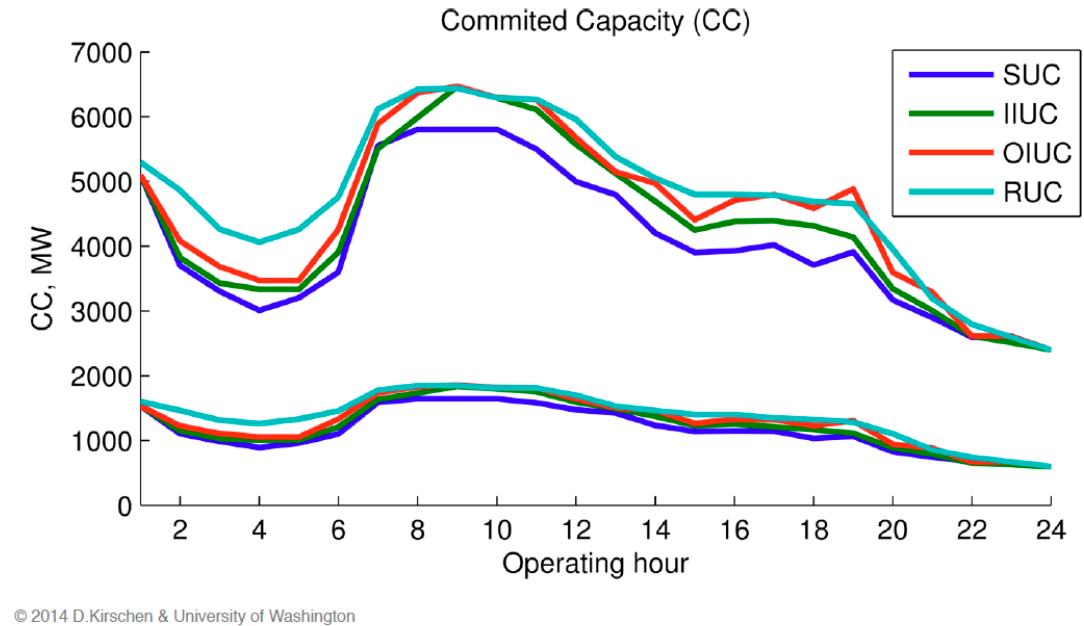
Figure 3. Committed capacity using different UC models and different wind profile (favorable for the upper group of lines and unfavorable for the lower group of values), source: Kirschen [34]. 251